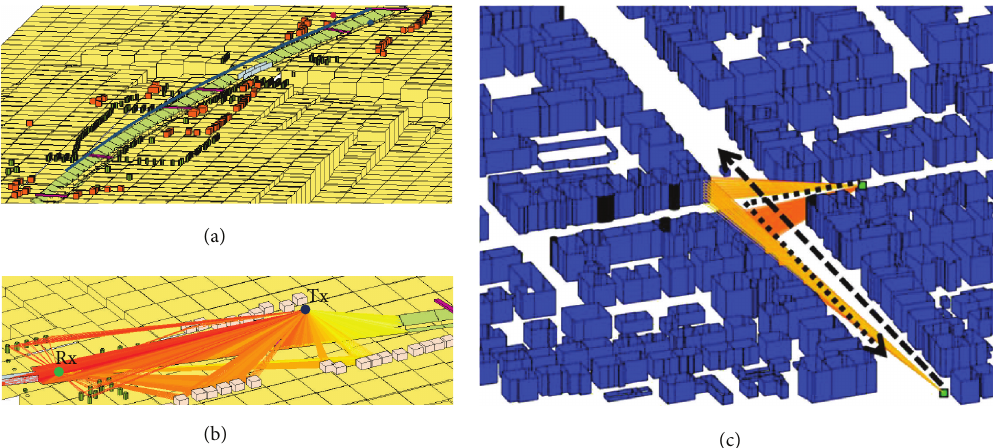
Figure 5: Example of (a) a ray-tracing map of the realistic high-speed railway scenario; (b) partial enlarged drawing for direct, reflected, and scattering paths in one snapshot; (c) and a ray-tracing map of a typical urban V2V